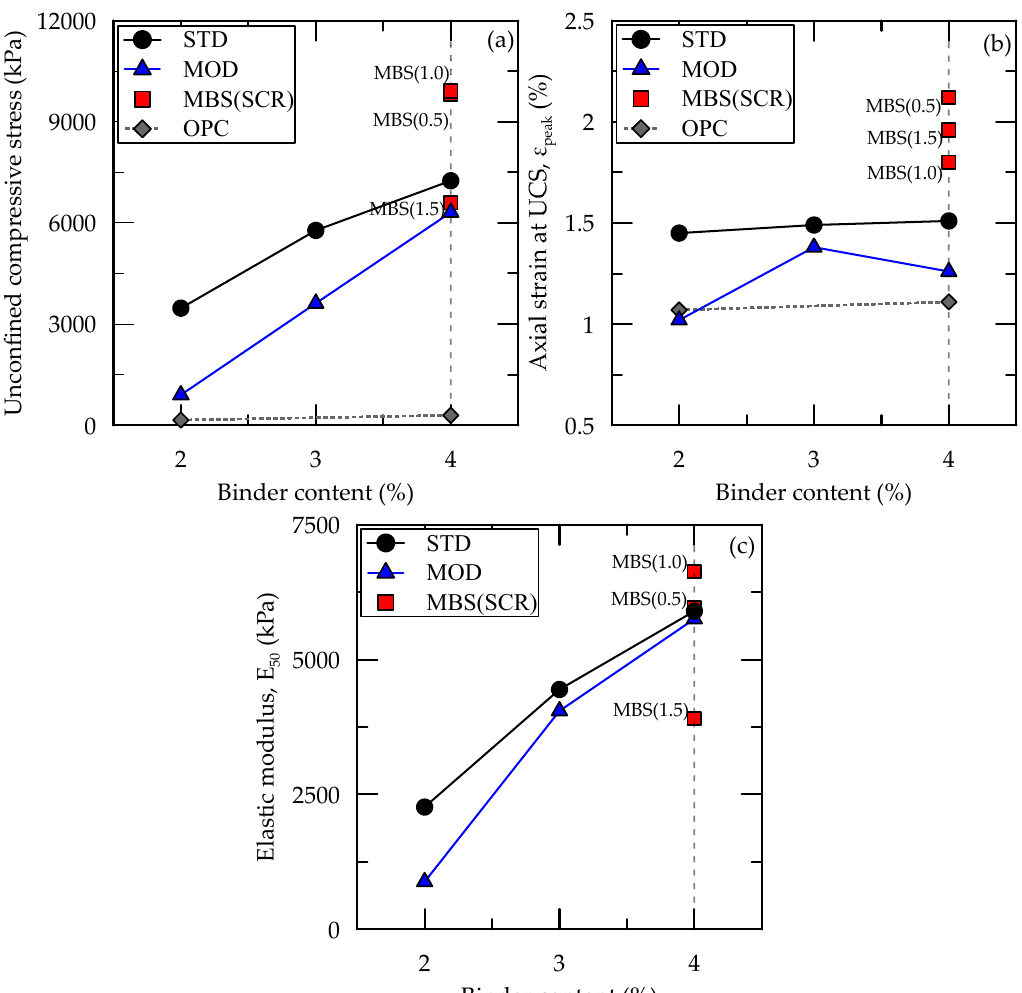
Figure 8. Stress-Strain relationship of casein and/or slag cemented ( a ) STD, ( b ) MOD, and ( c ) MBS samples.